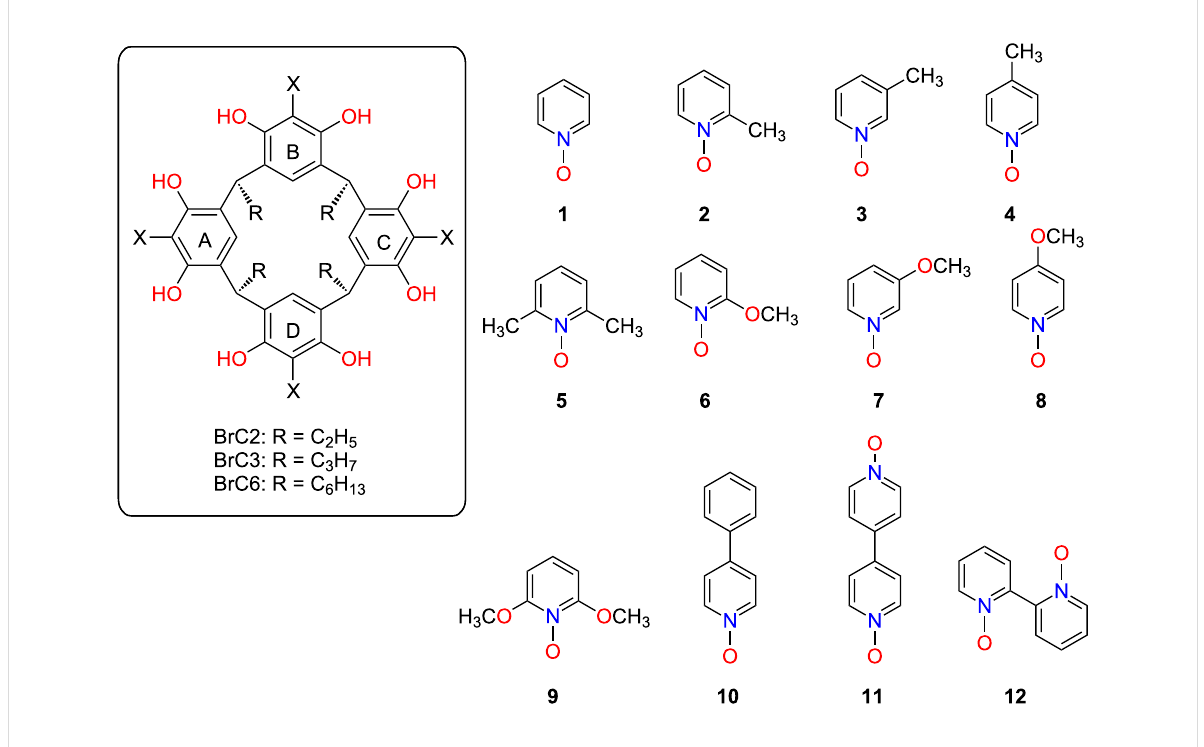
Figure 1: The chemical structures of C -ethyl-2-bromoresorcinarene (BrC2), C -propyl-2-bromoresorcinarene (BrC3) and C -hexyl-2-bromoresor- cinarene (BrC6) as hosts and pyridine N -oxide ( 1 ), 2-methylpyridine N -oxide ( 2 ), 3-methylpyridine N -oxide ( 3 ), 4-methylpyridine N -oxide ( 4 ), 2,6- dimethylpyridine N -oxide ( 5 ), 2-methoxypyridine N -oxide ( 6 ), 3-methoxypyridine N -oxide ( 7 ), 4-methoxypyridine N -oxide ( 8 ), 2,6-dimethoxypyridine N- oxide ( 9 ), 4-phenylpyridine N -oxide ( 10 ), 4,4'-bipyridine N,N '-dioxide ( 11 ) and 2,2'-bipyridine N,N '-dioxide ( 12 ) as guests.